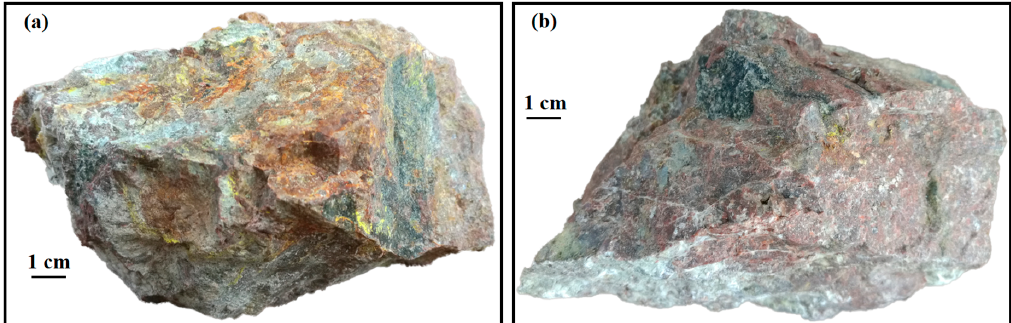
Figure 3. Specimen of the uranium ore from MHK. ( a ) The yellow and dark red minerals are oxidized uranium mineral and hematite. ( b ) The green dark minerals are agglomerate uraninite.